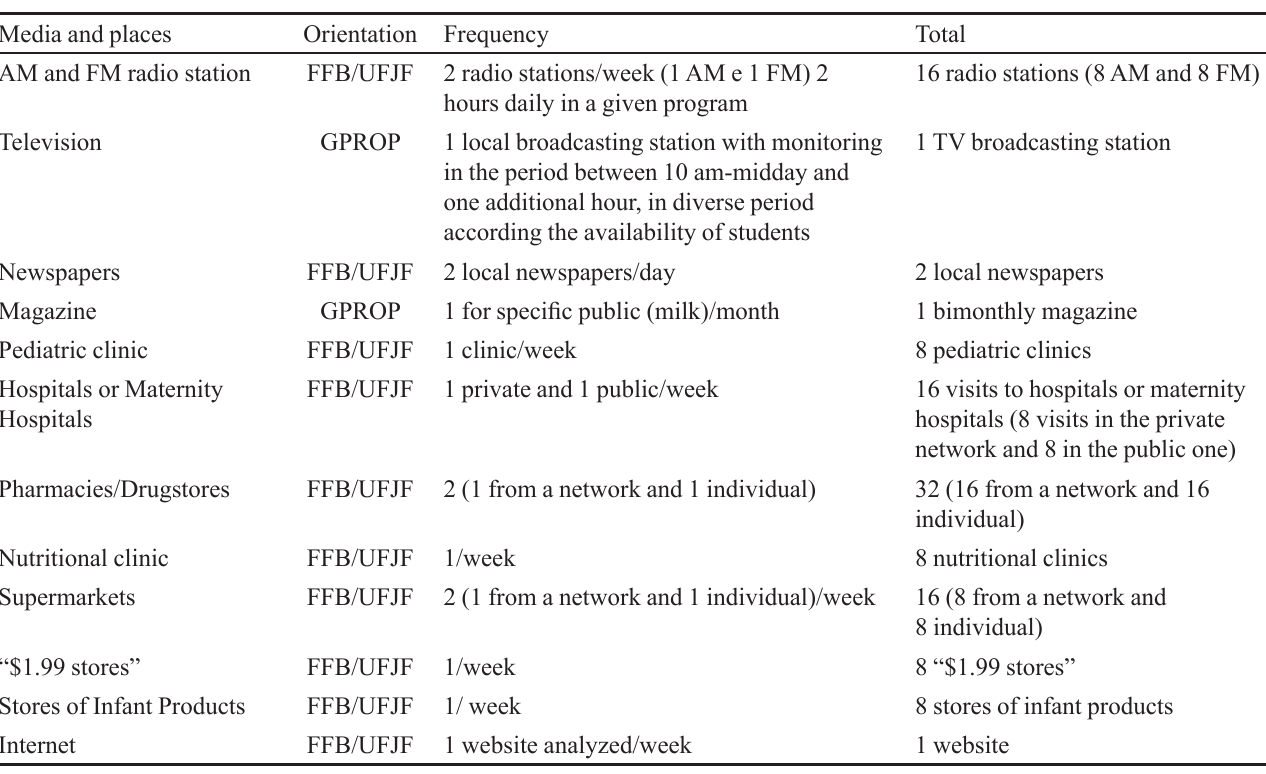
TABLE I - Presentation of media and places to be monitored, according orientation from GPROP or through a choice by FFB/UFJF, with indication of monitoring frequency Media and places